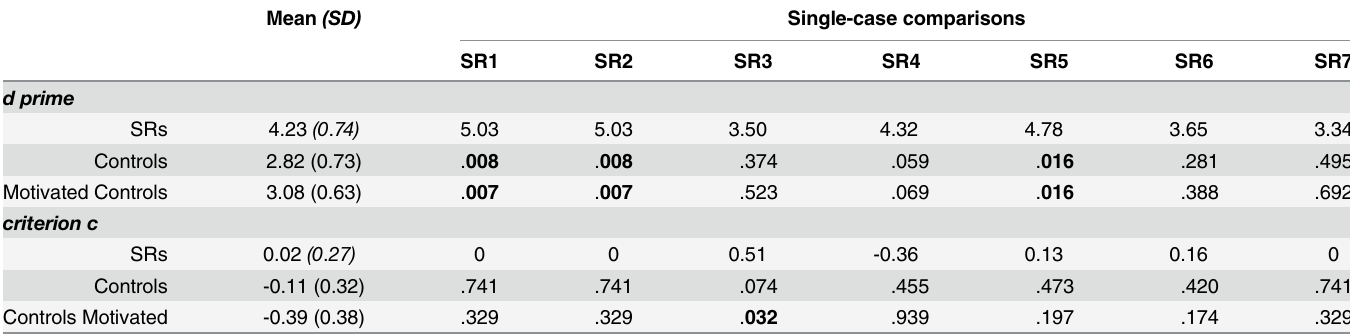
Table 3. Individual case analyses of sensitivity of SRs in GFMT, using modified t-tests for single-case comparisons [30]. Mean (SD) Single-case